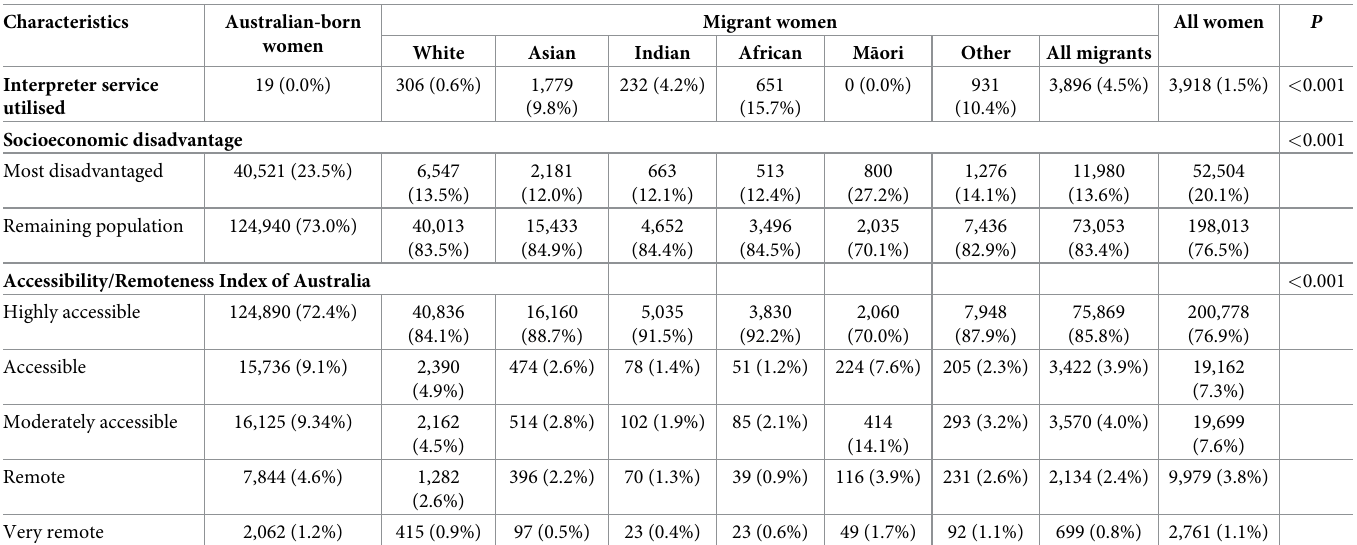
In the multivariable analysis, primiparity, living in remote areas, private health insurance, and utilising interpreter services were associated with lower risk of AnteSB (Table 3), whereas